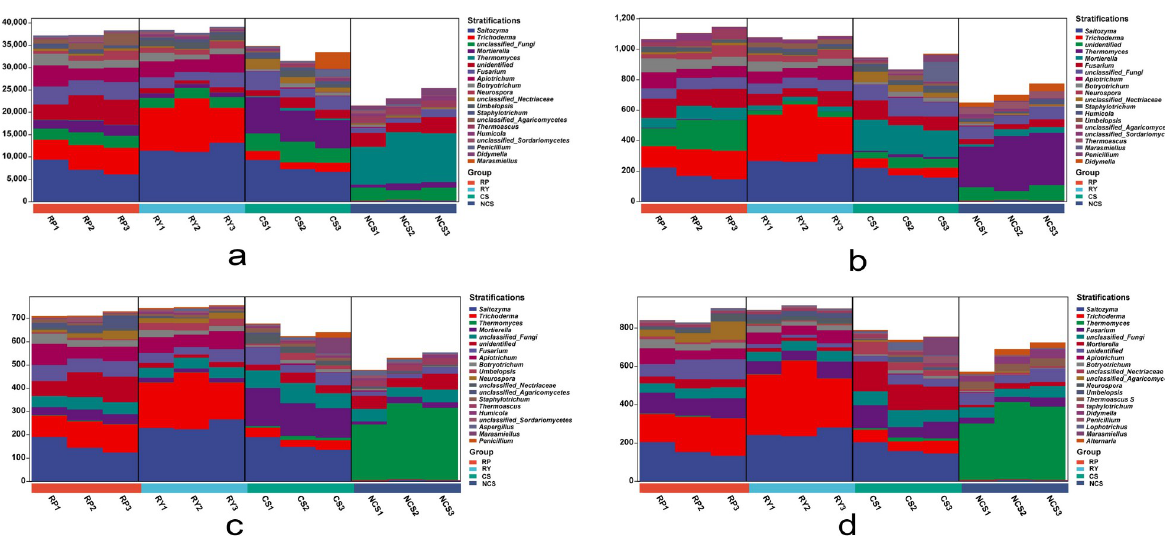
Fig 8. Contribution of fungal genera to different metabolic pathways. Different colours represent the contributions of different taxa to the glycolysis pathway (a), the glyoxylic acid pathway (b), the phosphopantothenic acid biosynthesis (c) and the non-oxidative pentose phosphate pathway (d) at the genus level (the first 20